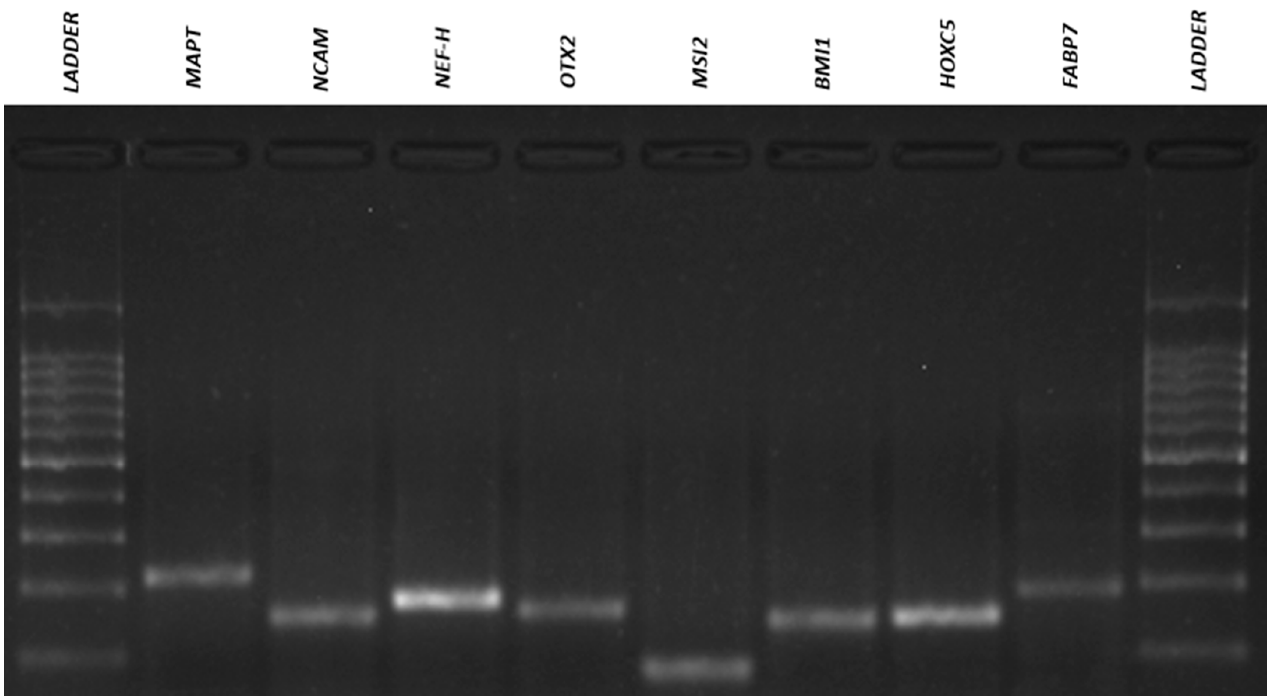
Figure 10. NPs electrophoresis gel. RT-PCR for amplification of MAPT (218bp), NCAM (150bp), NEF-H (179bp), OTX2 (163bp), MSI2 (84bp), BMI1 (148bp), HOXC5 (149bp) and FABP7 (233bp) genes in NPs. NPs, neural precursors.